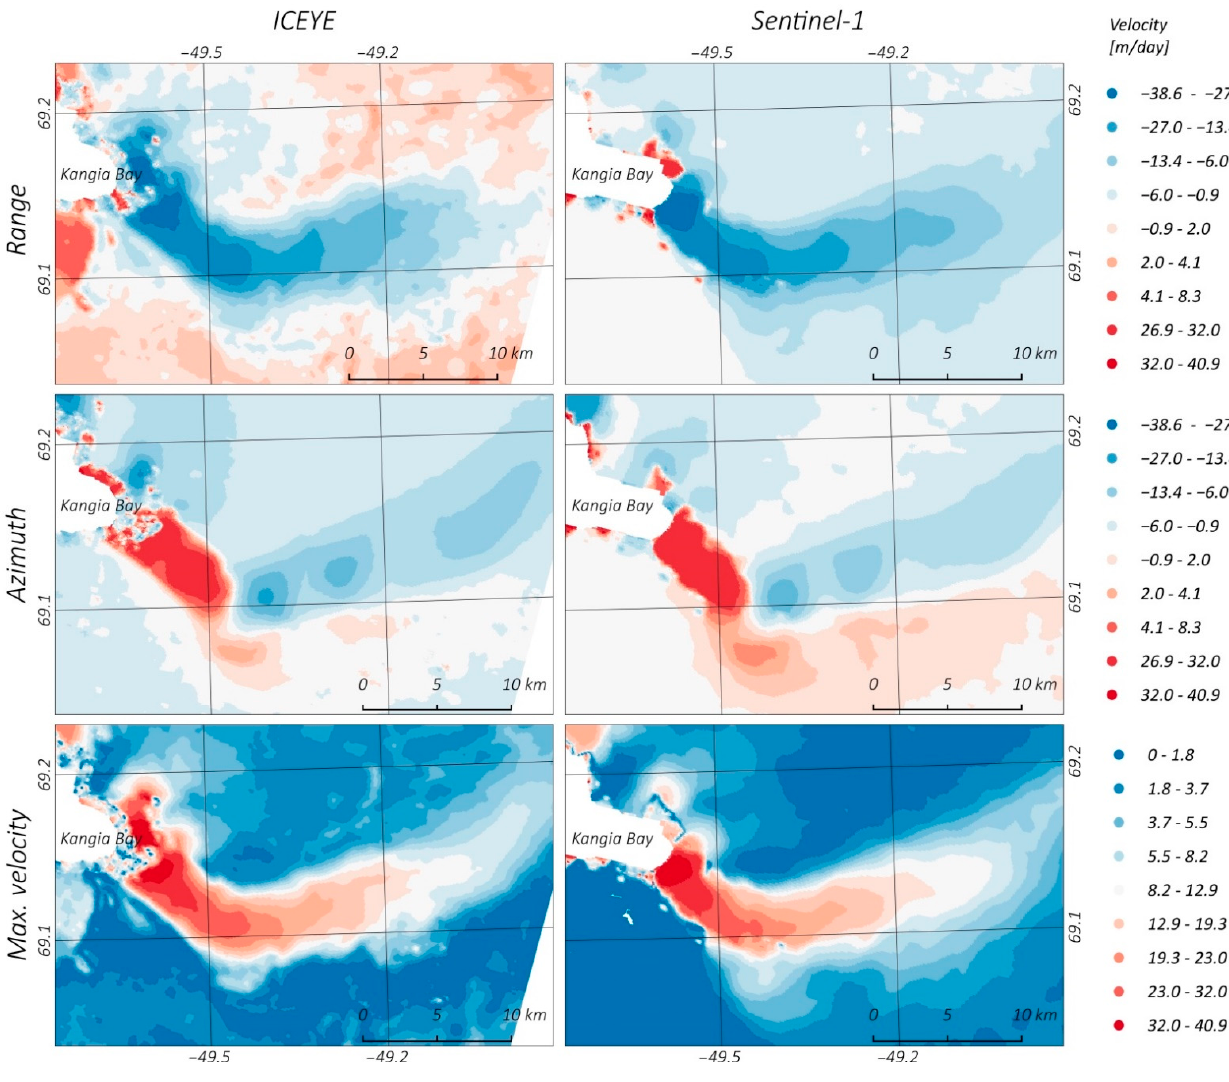
Figure 3. Distribution of displacements in range and azimuth directions and maximum velocities obtained using radar images from the ICEYE and Sentinel-1 sensors.